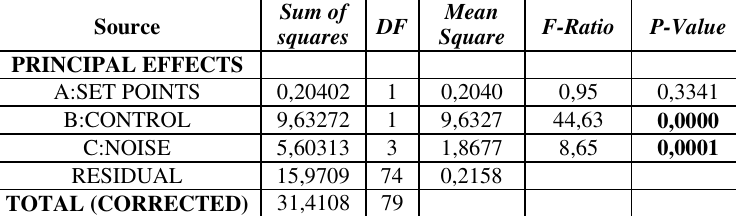
Table 8. Analysis of Variance for MSE (sum of squares type III).